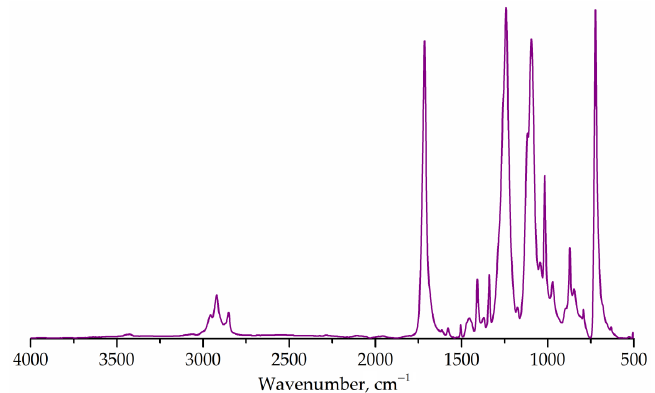
Figure 2. FTIR spectrum of PET flakes.